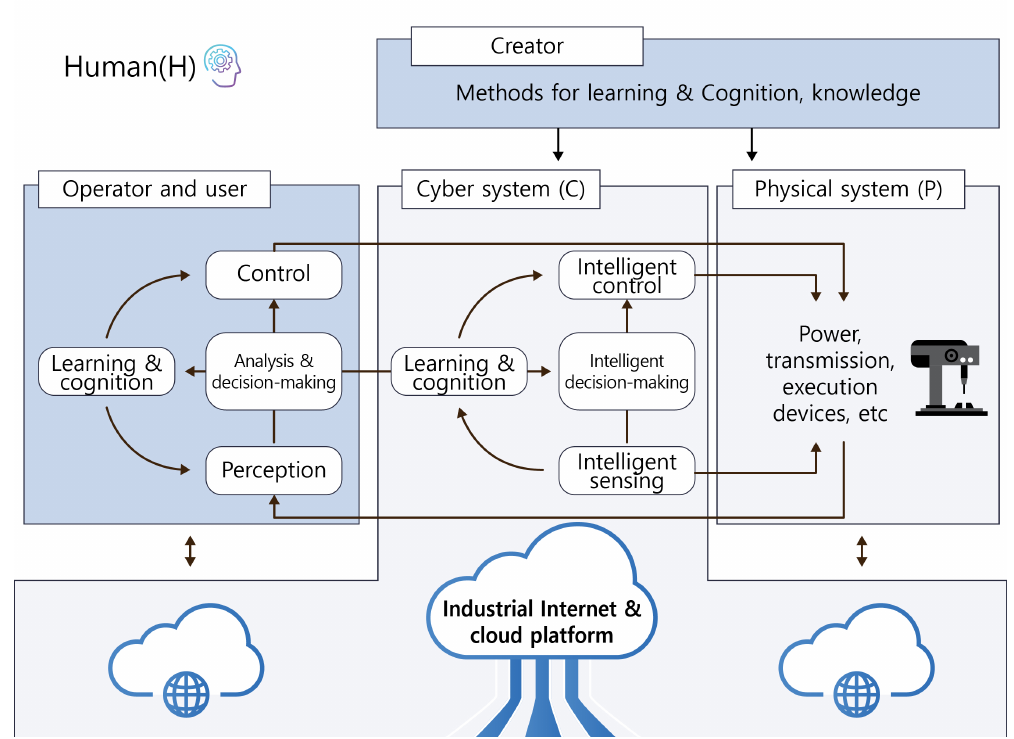
Figure 2. The configuration of NGIM HCPS 2.0